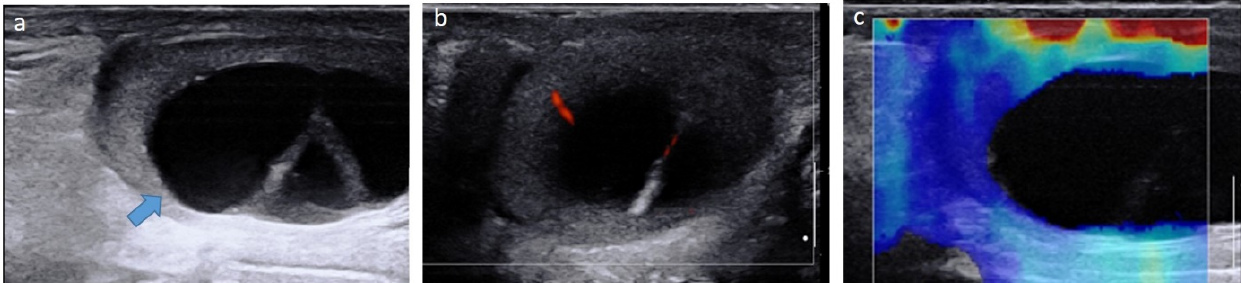
Figure 1. Mature cystic teratoma in a 4-month-old boy. Longitudinal gray-scale B mode ( a ), color Doppler ( b ) and strain elastography ( c ) US of the testis. Images show a cystic intra-testicular lesion (blue arrow) containing two inner septa with color Doppler signals and no signals on elastography. Serum levels of tumor markers were normal. The patient underwent conservative surgery. US, ul- trasonography.